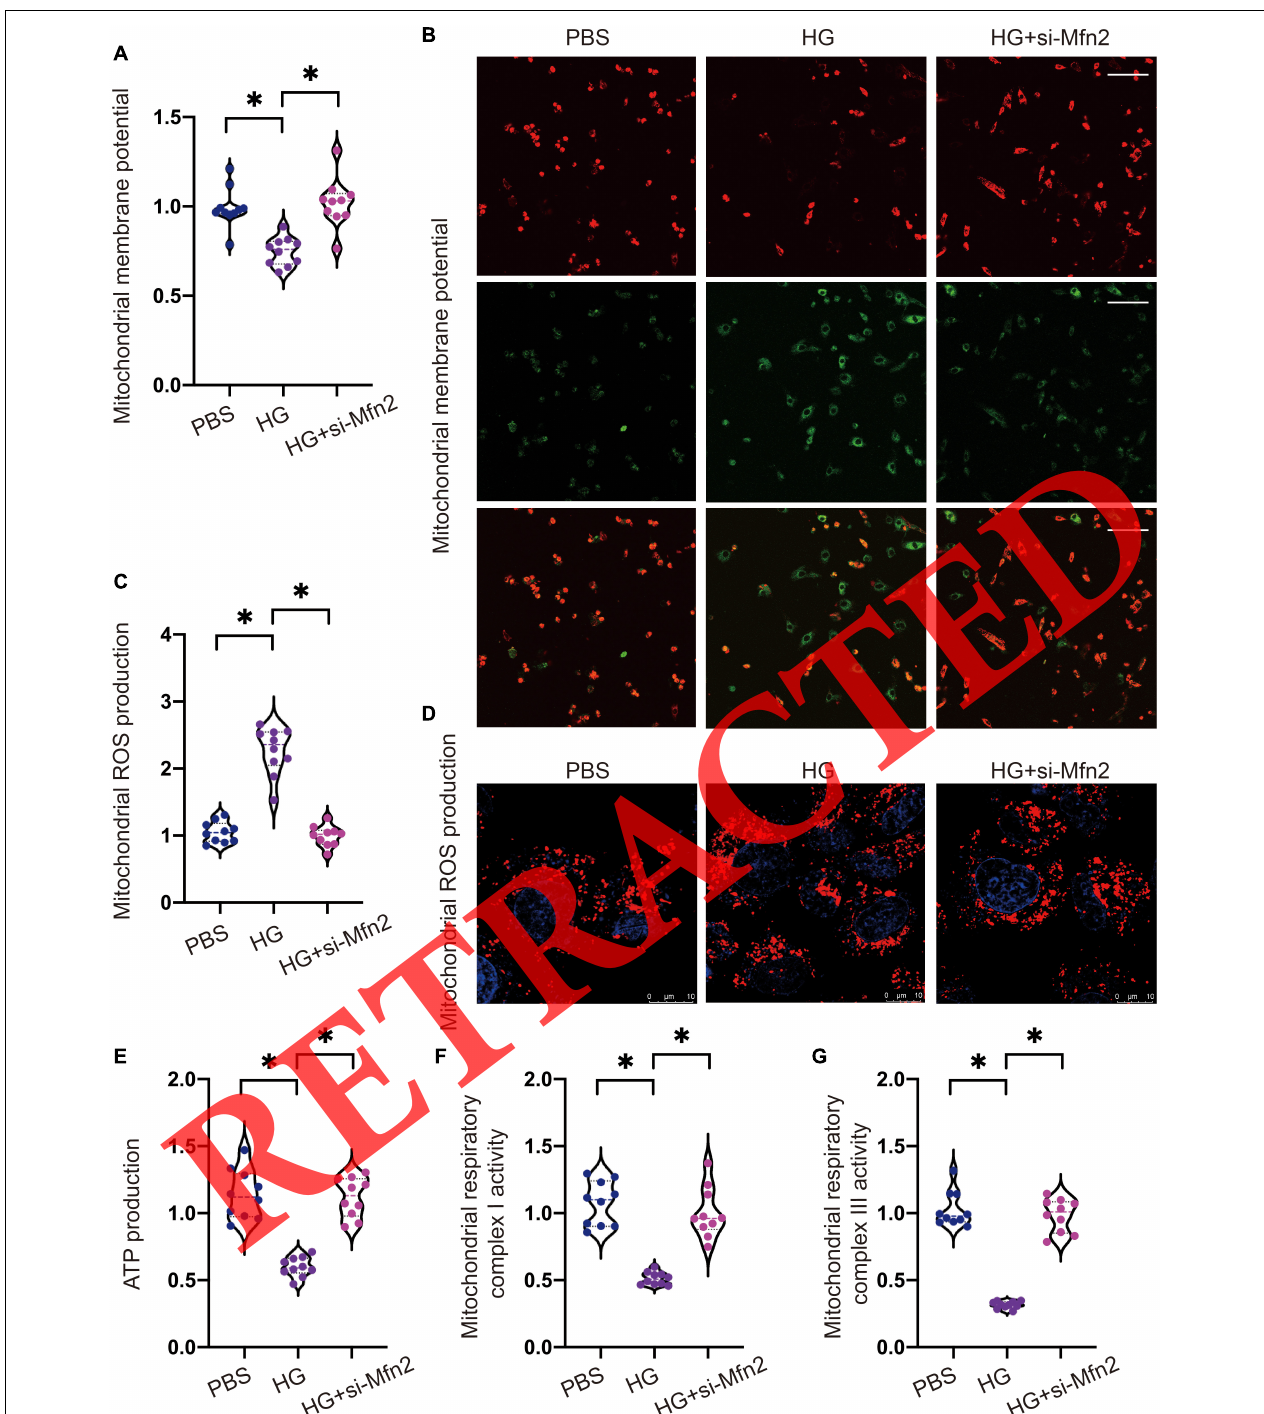
FIGURE 4 | Mfn2 silencing sustains mitochondrial function in cardiomyocytes under hyperglycemic conditions. (A,B) A JC-1 probe was used to detect changes in the mitochondrial membrane potential. (C,D) Immunofluorescence was used to observe mitochondrial ROS levels in hyperglycemia-treated cardiomyocytes. (E) ATP production was determined through an enzyme-linked immunosorbent assay (ELISA). (F,G) An ELISA was used to analyze mitochondrial respiratory complex I and III activity. ∗ p < 0.05.